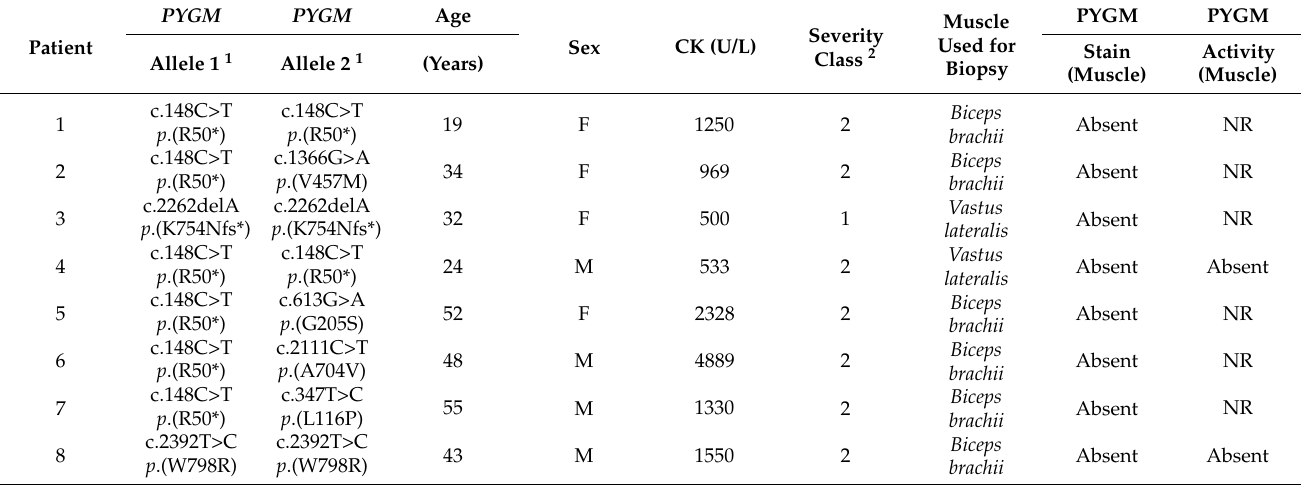
Table 1. Demographic and disease characteristics of the GSDV patients.